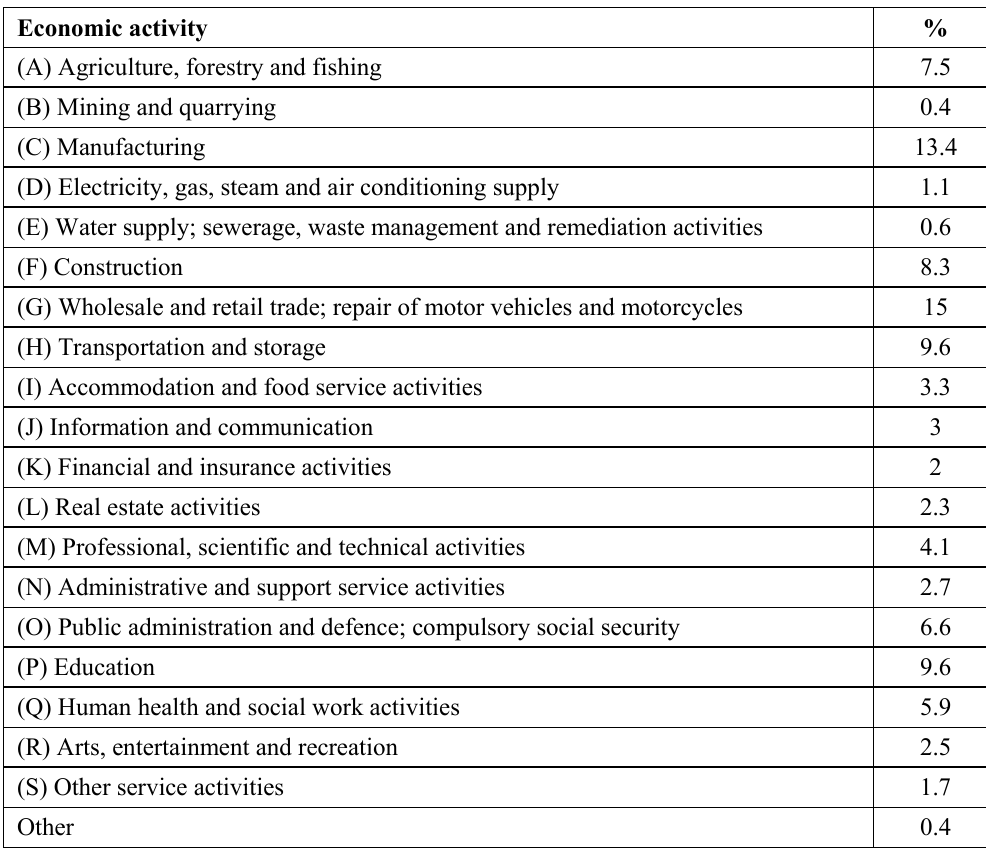
Table 2. The Employed by Economic Activity in Latvia in 2014 (%). (NACE Rev. 2.) (Central Statistical Bureau of Latvia,